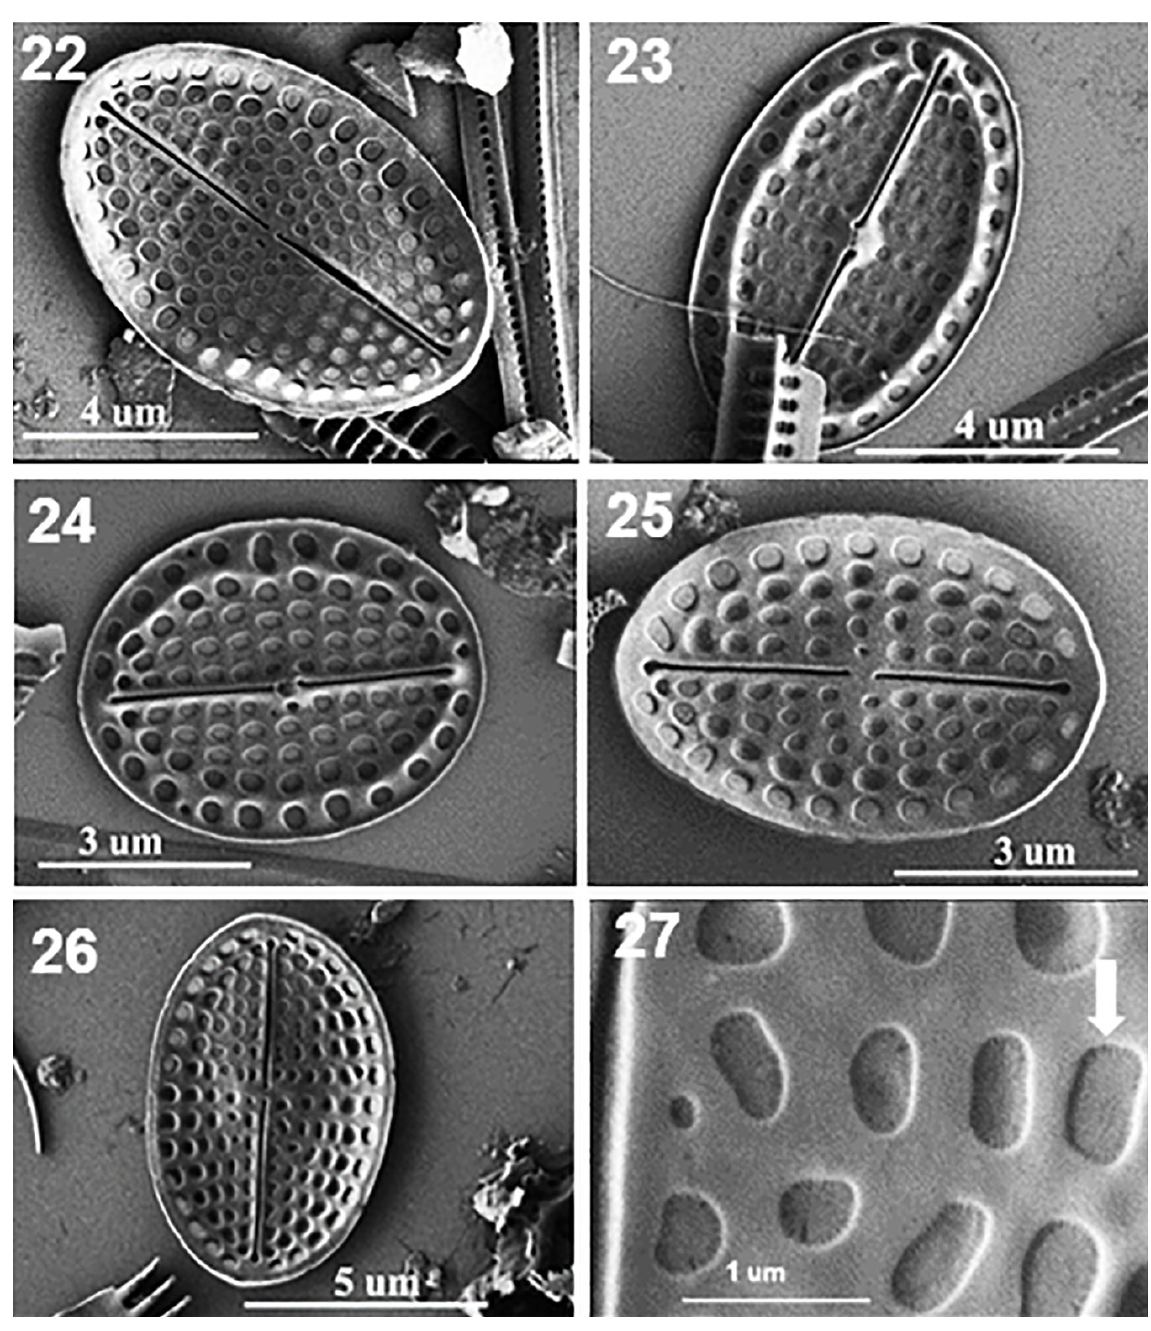
Figs 22–27. SEM images of C. magnoareolata Al-Handal, Riaux-Gob., R.Jahn & A.K.Wulff sp. nov. (BGBM, slide B 40 0043104). 22 , 25 – 26 . External view of the outline and stria density of the RV. 23–24 . Internal view of the RV exhibiting the slightly raised central area and the submarginal rim. 27 . Enlarged part of the external face of raphe valve showing RV hymenes with a row of short marginal slits